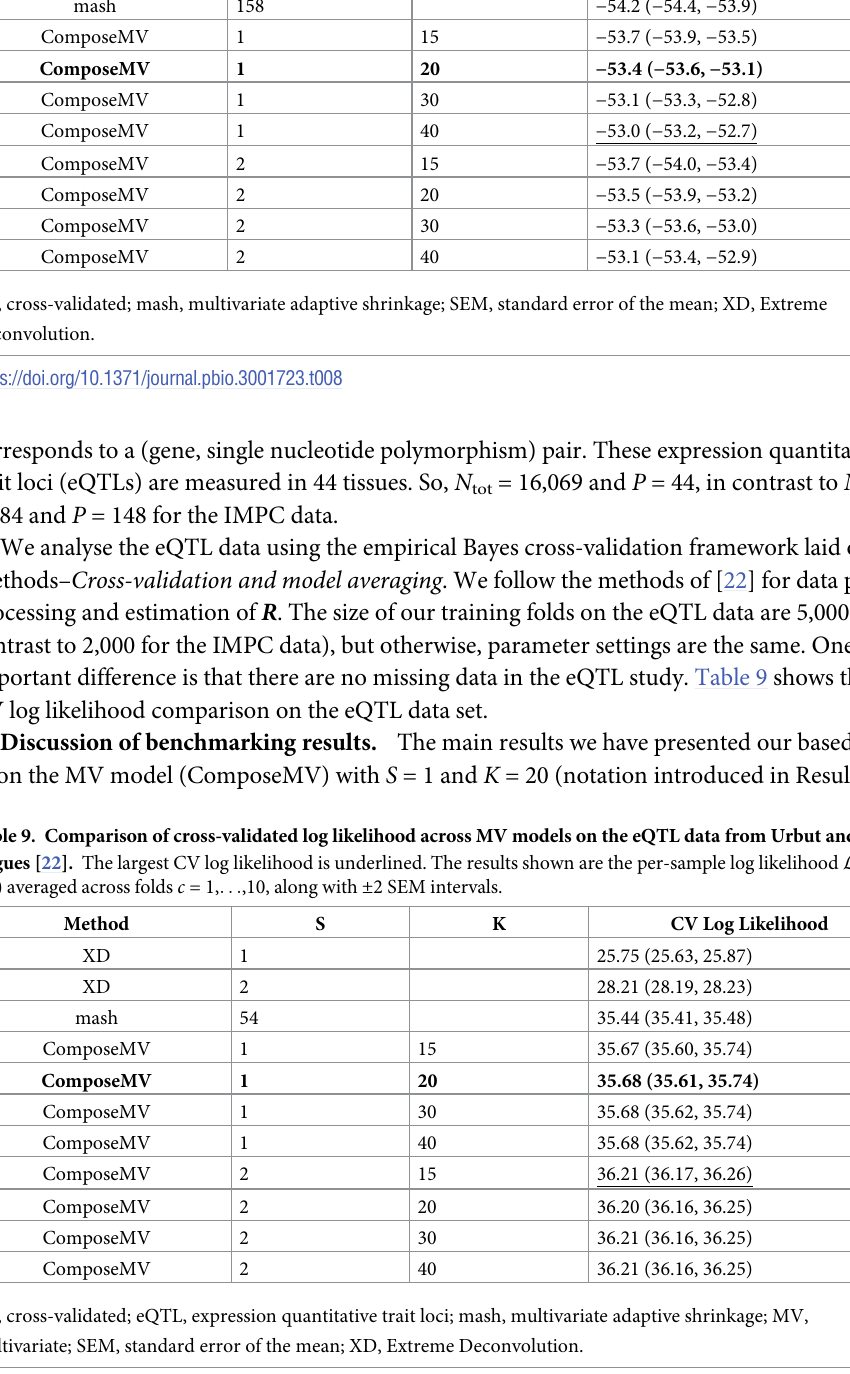
CV, cross-validated; eQTL, expression quantitative trait loci; mash, multivariate adaptive shrinkage; MV, multivariate; SEM, standard error of the mean; XD, Extreme